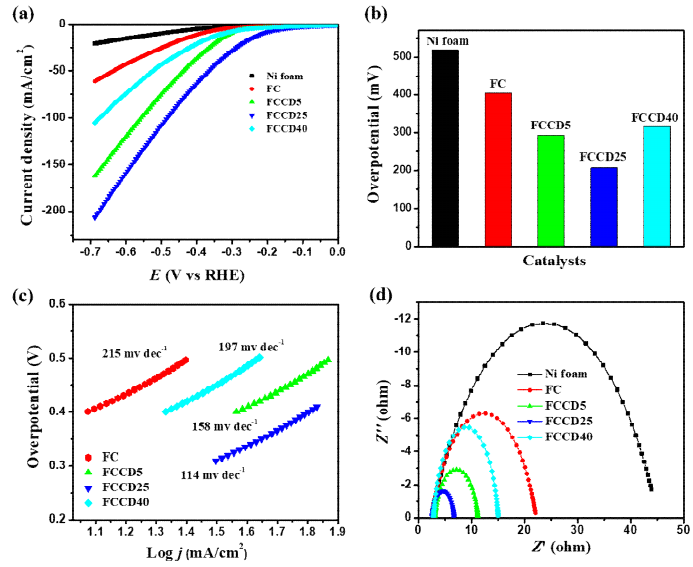
Figure 4. ( a ) Hydrogen evolution reaction (HER) polarization curves, ( b ) overpotential histogram, ( c ) Tafel plots and ( d ) Nyquist plots of different electrocatalysts. The long-term stability of catalysts is also important and becomes a key feature for water reduction and oxidation processes. To investigate this factor in terms of the HER process, 1000 CV cycles were measured on the FC and FCCD25 electrodes. Figure 5a shows that after 1000 CV cycles, the polarization curve remains the same at a low current density region for FC, but it deviates in a high current density region. However, for FCCD25 (Figure 5b), the polarization curve almost coincides with the initial one. Furthermore, FCCD25 exhibits excellent electrochemical durability chronopotentiometric study. The above results clearly demonstrate the pivotal role of CDs in providing the electrochemical stability to the electrocatalyst.